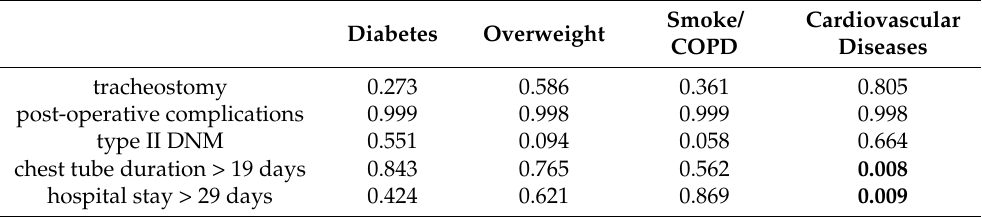
Table 3. Multivariate analysis results for the risk of a worse course of DNM ( p -value is reported, in bold when statistically